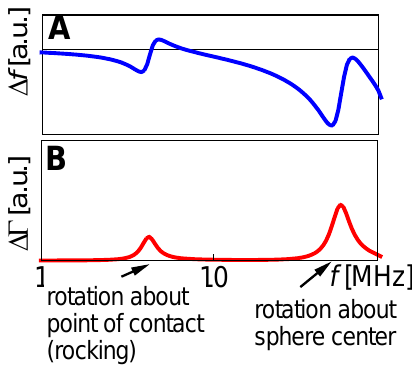
Figure 36. Shifts of frequency in panel ( A ) and bandwidth in panel ( B ) as computed with an FEM simulation for the configuration shown in Figure 35. There are two separate coupled resonances. These are the consequence of two dynamical variables, which are translation and rotation. Translation and rotation are always coupled, but there are two special linear combinations of translation and rotation, which both produce a resonance. Only the transverse force at the point of contact shifts Δ f and ΔΓ , a torque does not take an influence. The relative importance of the force compared to the torque is larger for the high-frequency mode. The sphere rotating about the point of contact mostly exerts a torque. This low-frequency mode therefore appears as less pronounced when probed with the QCM. Adapted from [171].